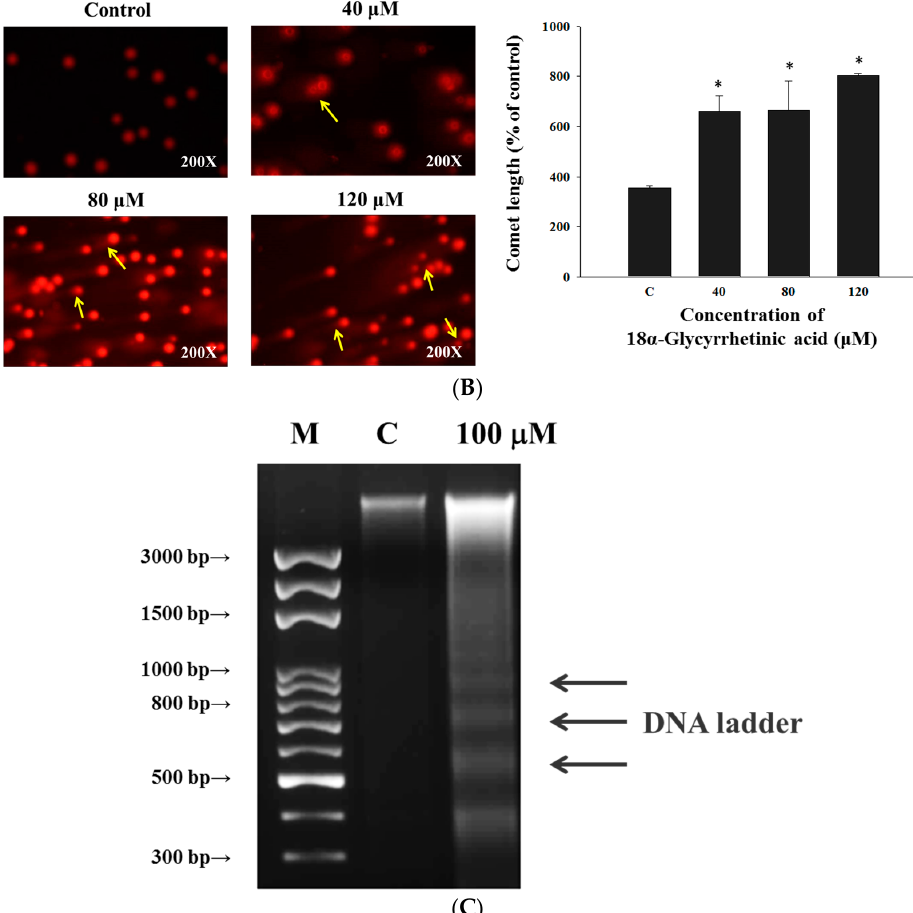
Figure 2. 18 α -GA induced nuclear condensation, DNA damage and fragmentation in HL-60 cells. HL-60 cells were treated with 18 α -GA (0, 40, 80 and 120 μ M) for 48 h. Cells were stained with DAPI for measuring nuclear condensation ( A ) or cells were performed by Comet assay for DNA damage evaluated ( B ); Cells were treated with 100 μ M of 18 α -GA for 48 h and DNA was isolated for gel electrophoresis for examining DNA fragmentation ( C ) as described in the Materials and Methods section. * p < 0.05, significant difference between 18 α -GA-treated groups and control as analyzed by Student’s t test.